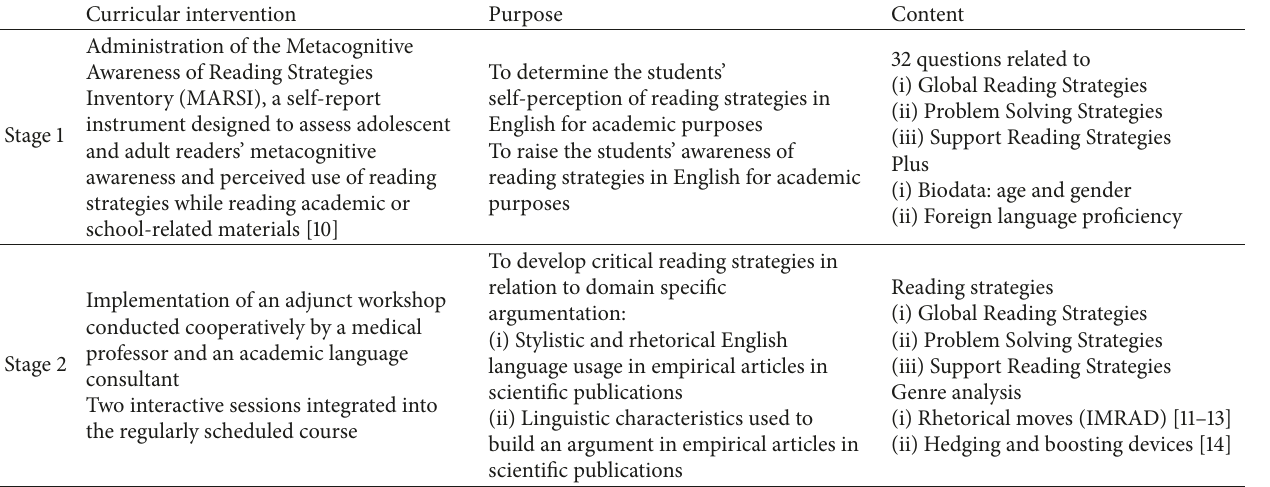
Table 1: Two-stage curricular